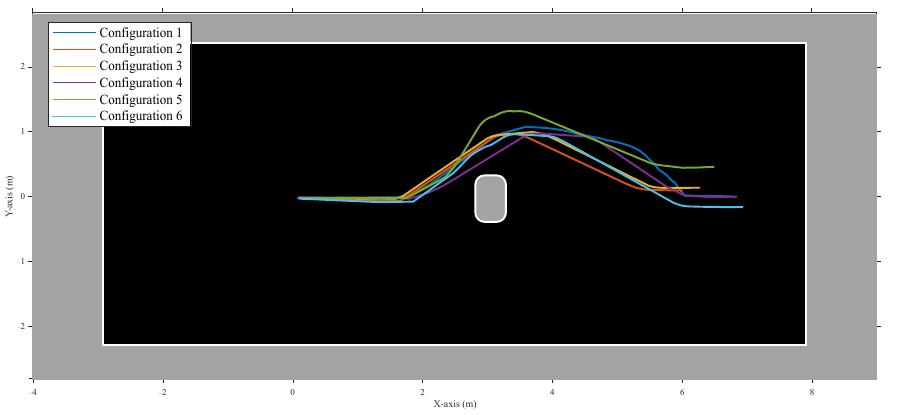
Figure 11. Experimental results for a real mobile platform navigating a room with an obstacle that needs to be dealt with safely. The room was empty except for the obstacle. The figure shows the trajectories of the six different configurations that were used for validating the adaptability of the layered controller. The trajectories were combined by using a single starting point. The map shown here is a manually cleaned-up version of the occupancy grid results of a LiDAR SLAM algorithm that was run offline. This figure shows avoiding a static obstacle, a chair in this instance. Although the behavior layer focused on here is obstacle avoidance, all layers were active during the